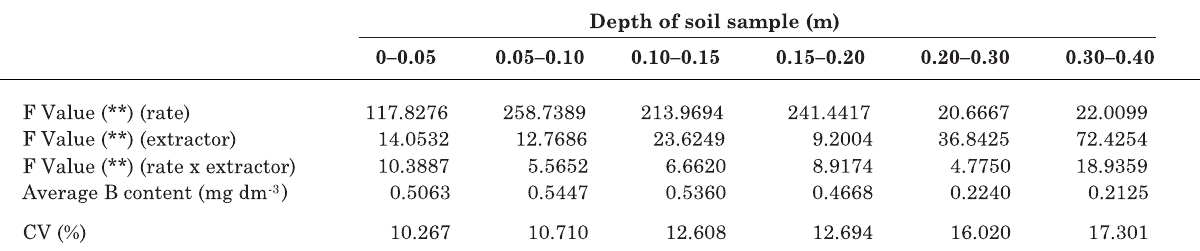
(**) significant at 1.0 % using SAS statistical program (SAS,